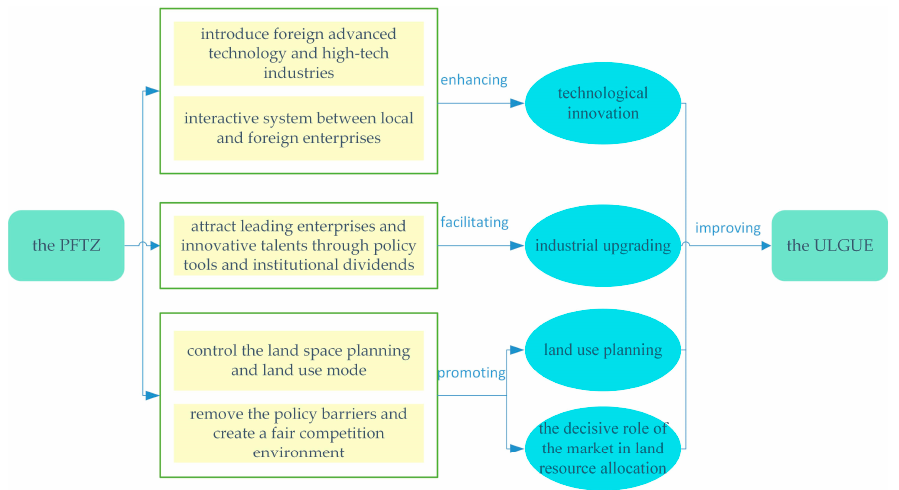
Figure 2. Theoretical